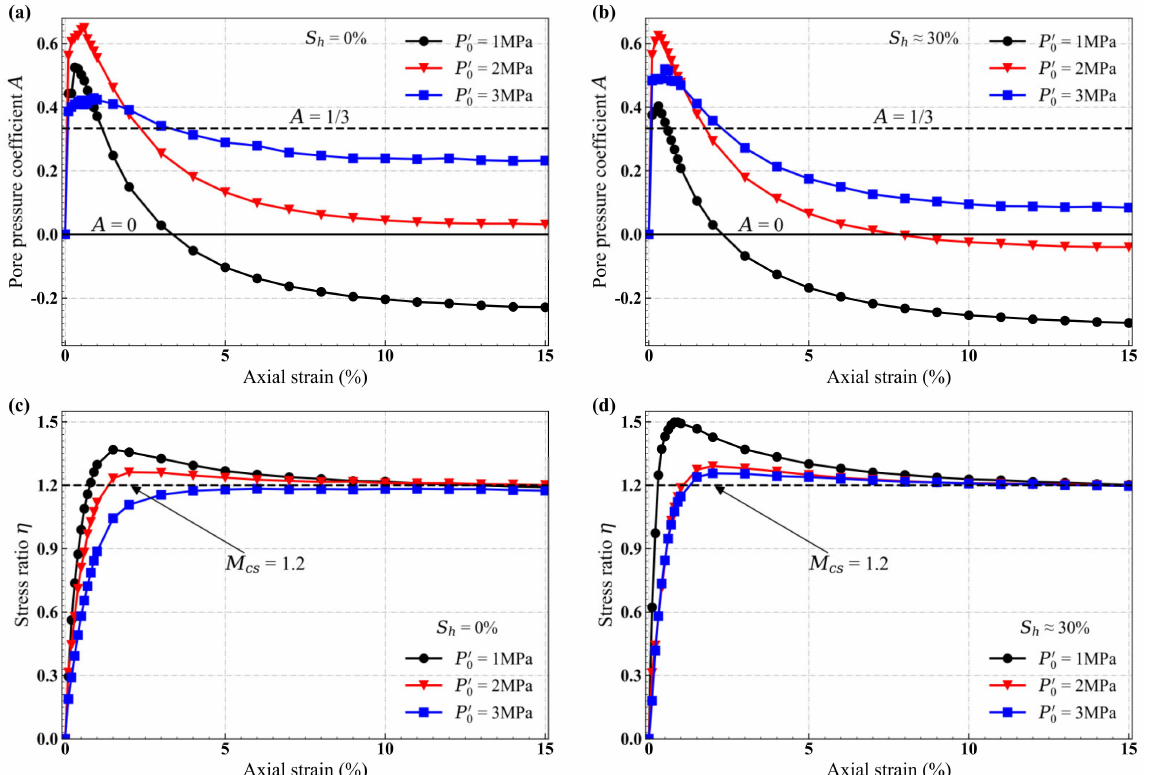
Figure 4. Effect of effective confining pressure on A value of sand sediments with ( a ) S h = 0%, ( b ) S h ≈ 30%, and effect of effective confining pressure on stress ratio η of sand sediments with ( c ) S h = 0%, ( d ) S h ≈